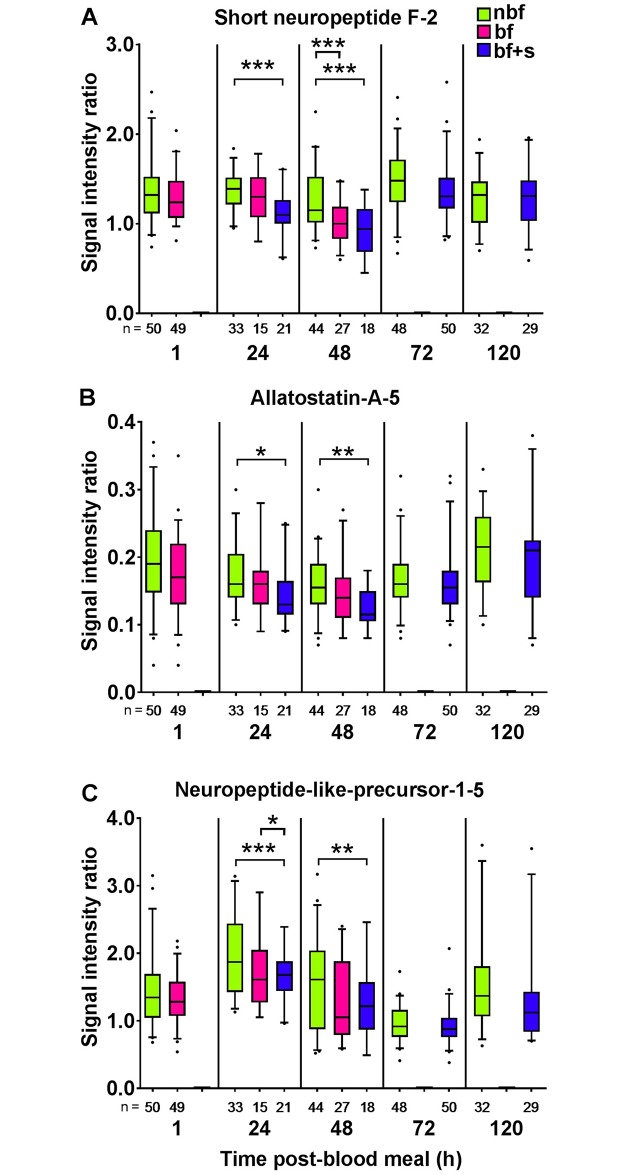
Regulation of neuropeptide levels in the antennal lobes of Aedes aegypti females in response to different feeding regimes.Box plots with whiskers representing the 5–95% percentile of signal intensity ratios of short neuropeptide F-2 (A), allatostatin-A-5 (B), and neuropeptide-like-precursor-1-5 (C) at 1 h, 24 h, 48 h, 72 h, and 120 h post-blood meal (pbm). The bar represents the 25–75 percentile, the line the median and the dots data points outside the 5–95% range. Nutritional state conditions of the mosquitoes are non-blood fed but sugar fed (nbf), blood fed (bf), and blood and sugar fed (bf+s). Due to transient sugar feeding inhibition of bf mosquitoes no data are available for bf+s females 1 h pbm. As mosquitoes consistently consumed sugar throughout the rest of the experiment, there are no data for bf females at 72 h and 120 h pbm. The n-values indicate the number of biological replicates of ALs from individual mosquitoes. Data were analyzed using a general linear model for each respective time point. Asterisks indicate significant differences between groups. Significance levels: *, p < 0.05; **, p < 0.01; ***, p < 0.001.